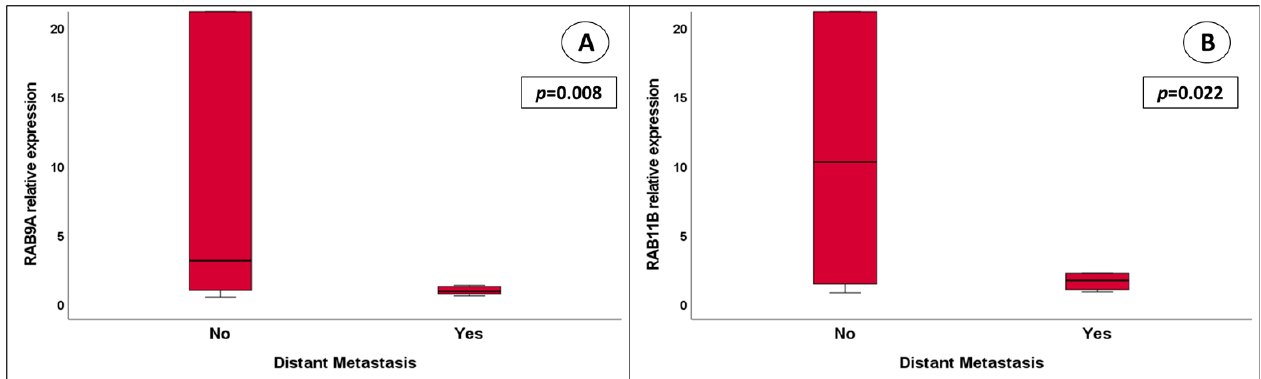
Figure 3. Relative gene expression of RAB9A ( A ) and RAB11B ( B ) with regards to the presence of distant metastases (n = 109). Patients with distant metastases have lower tumor expression of RAB9A and RAB11B .